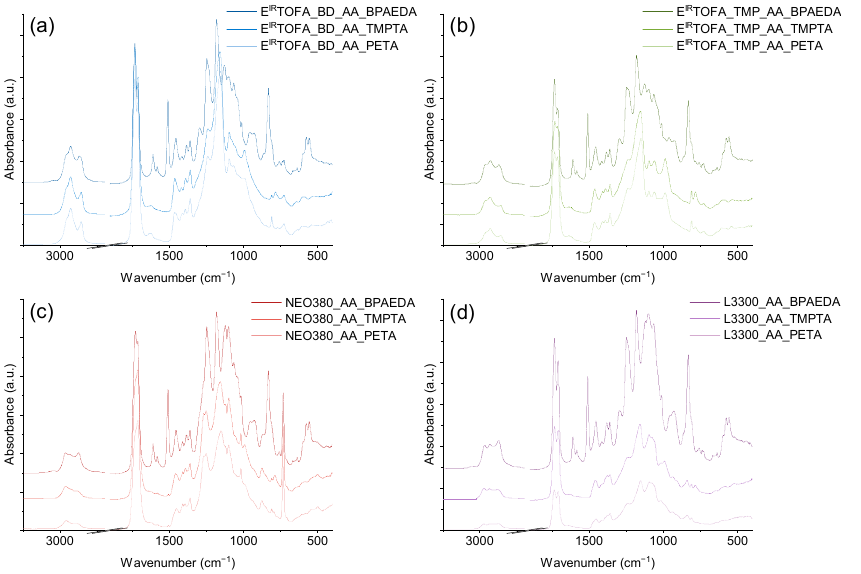
Figure 3. FTIR spectra of polymer monoliths from synthesized acetoacetates and BPAEDA, TMPTA, and PETA acrylates. ( a ) E IR TOFA_BD_AA polymers; ( b ) E IR TOFA_TMP_AA polymers; ( c ) NEO380_AA polymers; ( d ) L3300_AA polymers.